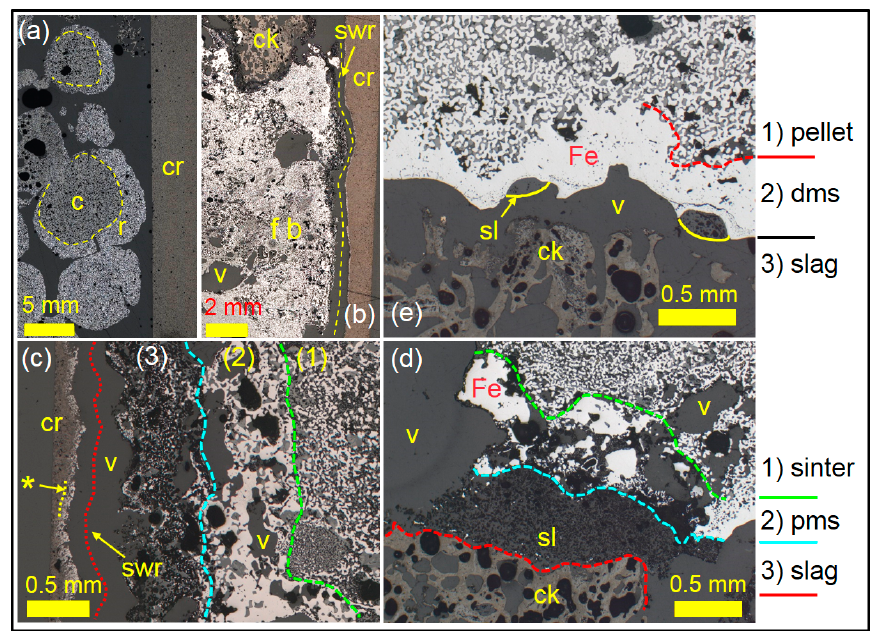
Figure 5. LOM imagery of various regions of interest. c = wustite-rich pellet core; r = metal-rich pellet rim; cr = crucible (graphite); ck = coke; swr = sidewall reaction interface; v = void; sl = slag; * = reaction intergrowth within crucible graphite. See text for further explanation.